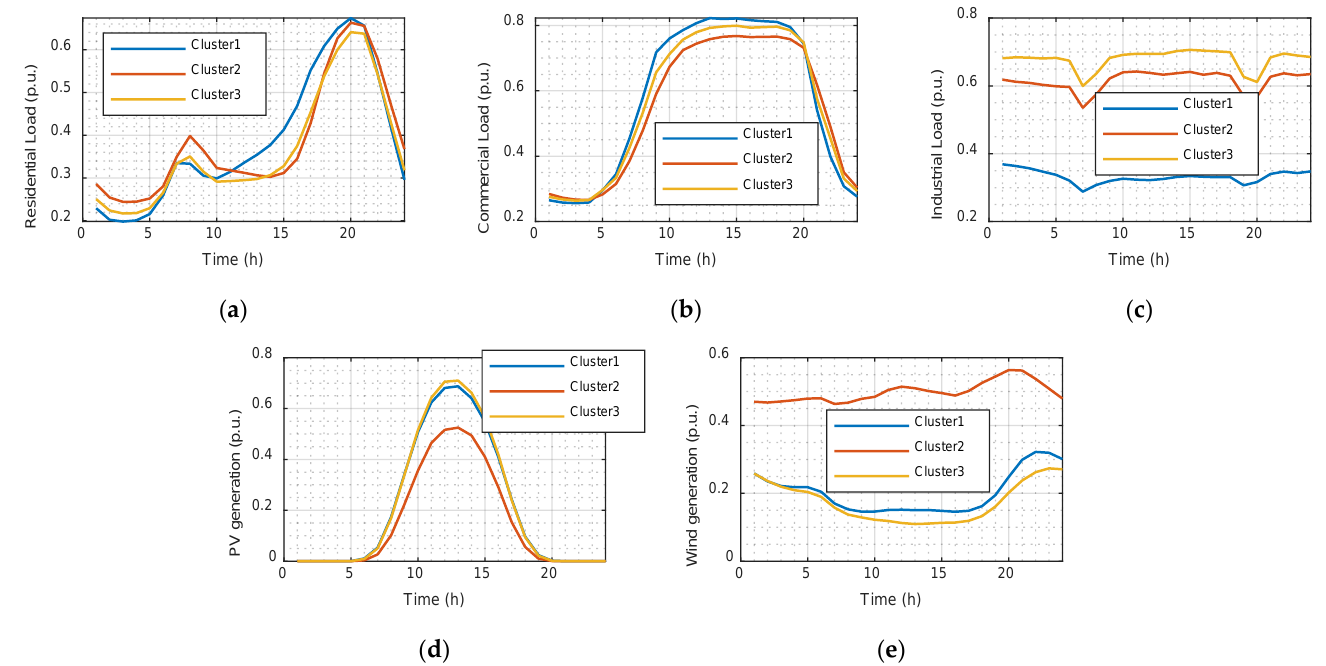
Figure 6. Cluster centers for the load and generation scenarios: ( a ) residential load; ( b ) commercial load; ( c ) industrial load; ( d ) PV generation; and ( e ) wind generation.